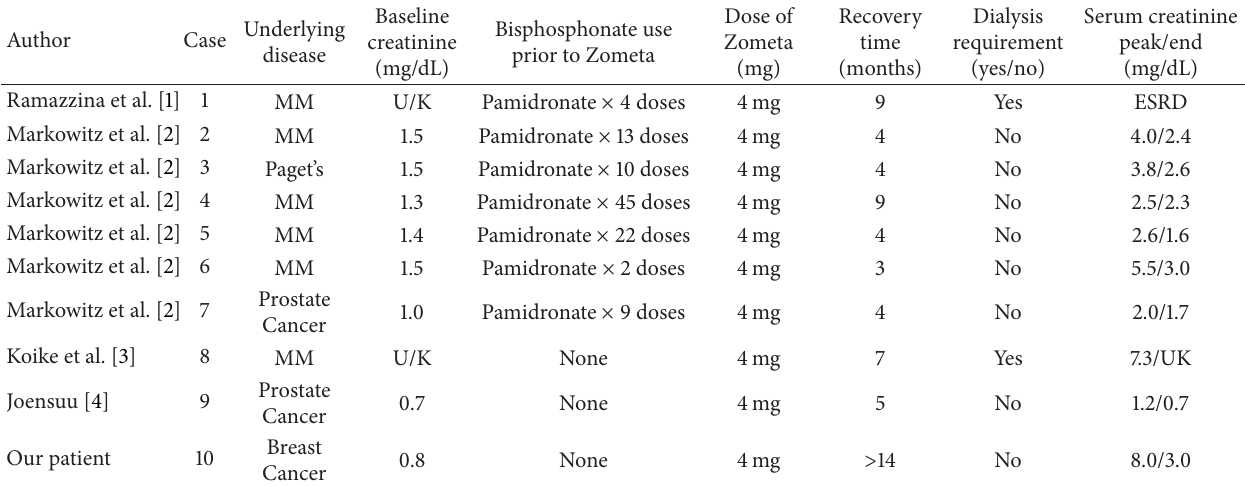
Table 2: Profile of reported cases of ARF associated with Zoledronic